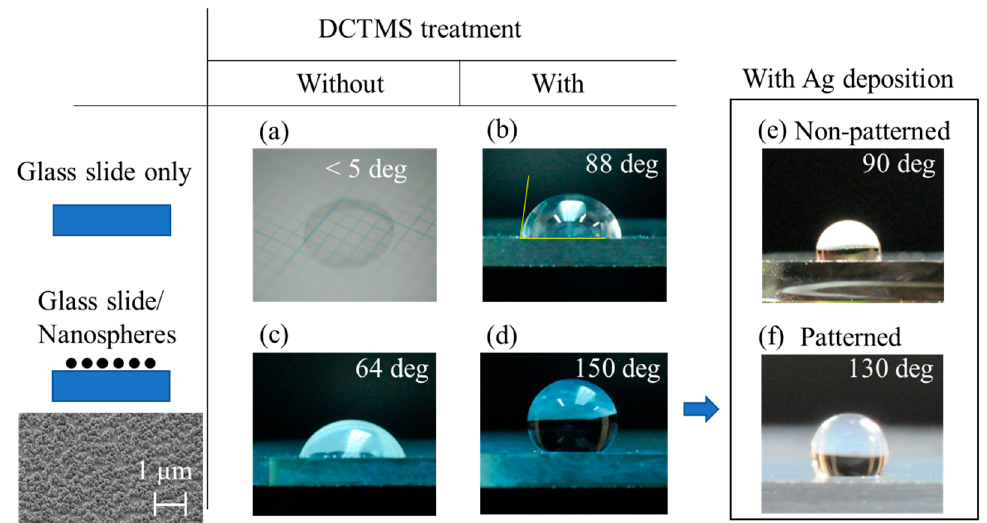
Figure 1. Photos of 1 µL water droplets placed on various surfaces. ( a ) plane glass slide as delivered, ( b ) glass slide treated with decyltrimethoxy silane (DCTMS), ( c ) glass slide covered by a